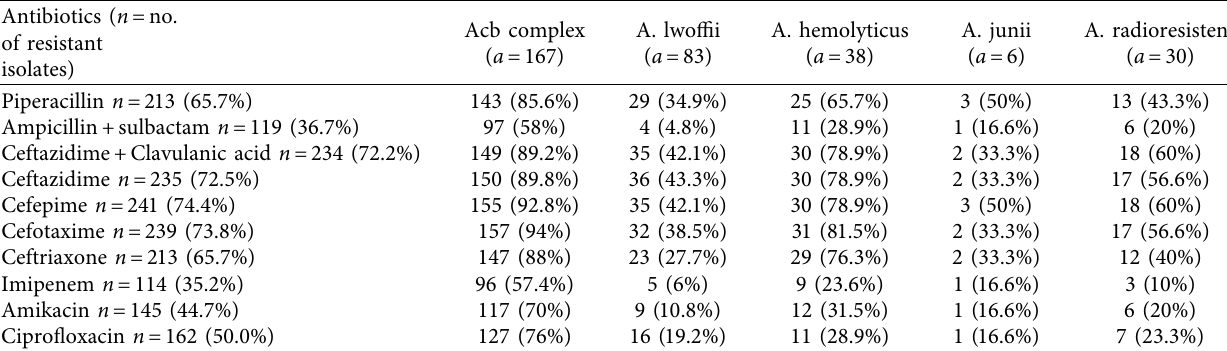
Table 2: Antibiotic resistance profle of isolated Acinetobacter species.